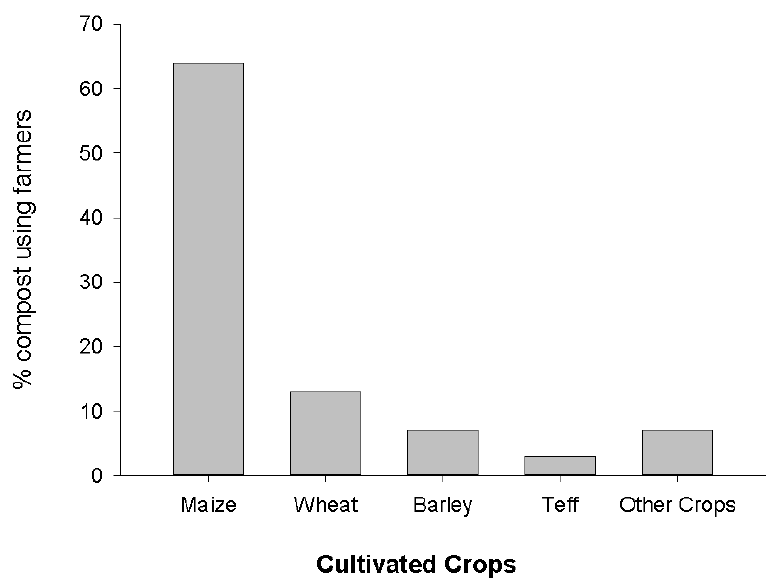
Figure 3. Compost use by smallholder farmers in Southern Ethiopia depending on the cultivated crop.